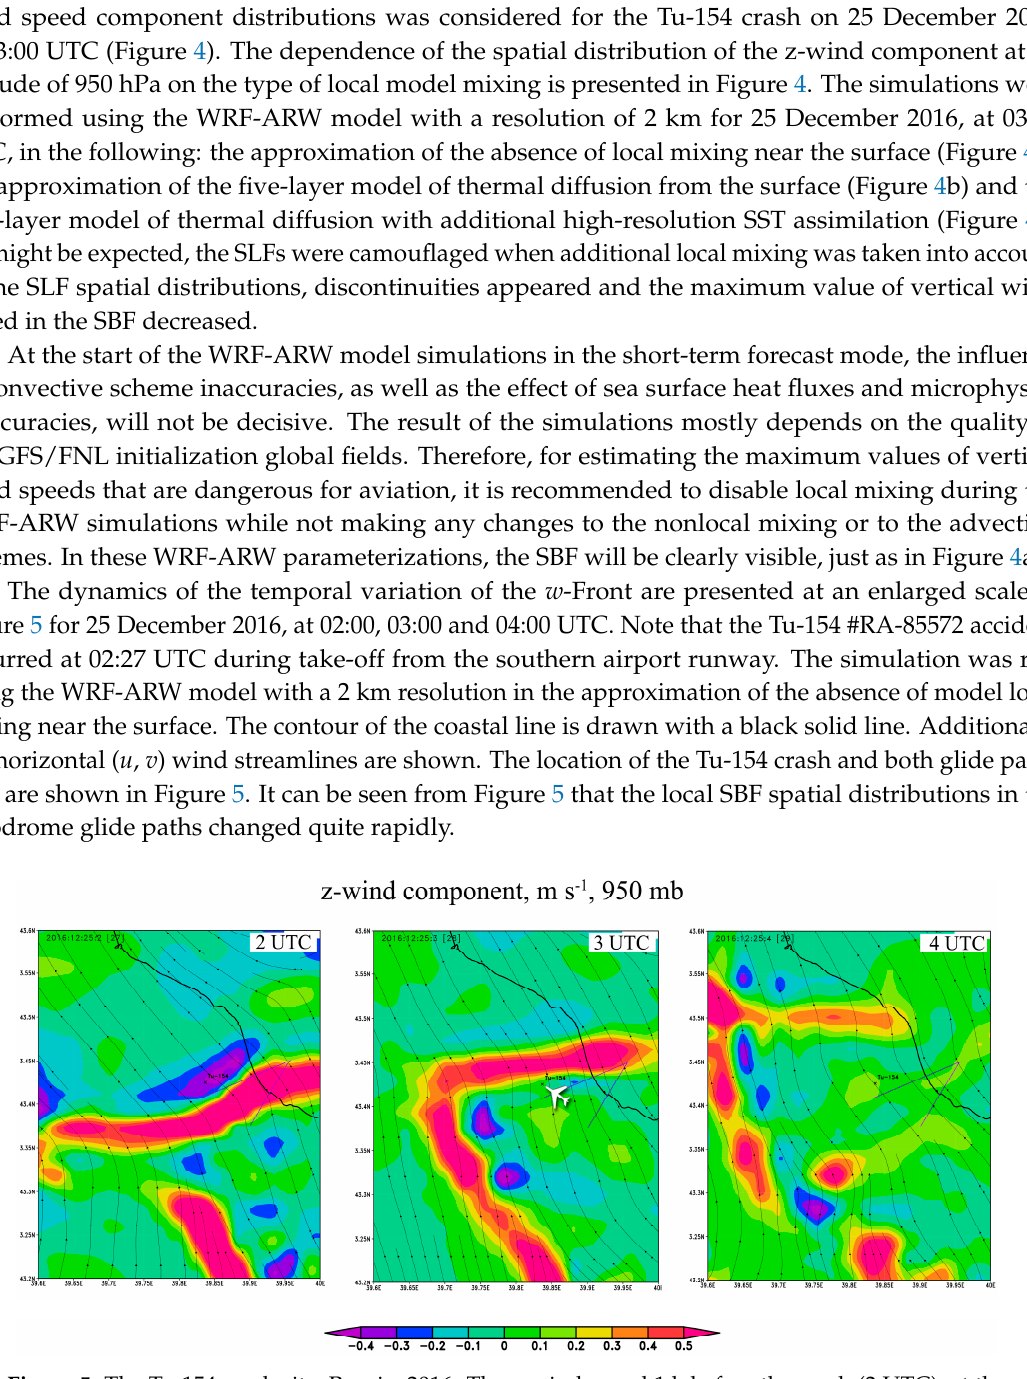
Figure 4. The Tu-154 crash site, Russia, 2016. The z-wind speed for three types of local mixing conditions near the surface: in the absence of local mixing ( a ); the five-layer model of thermal diffusion ( b ); thermal diffusion with additional SST assimilation ( c ).